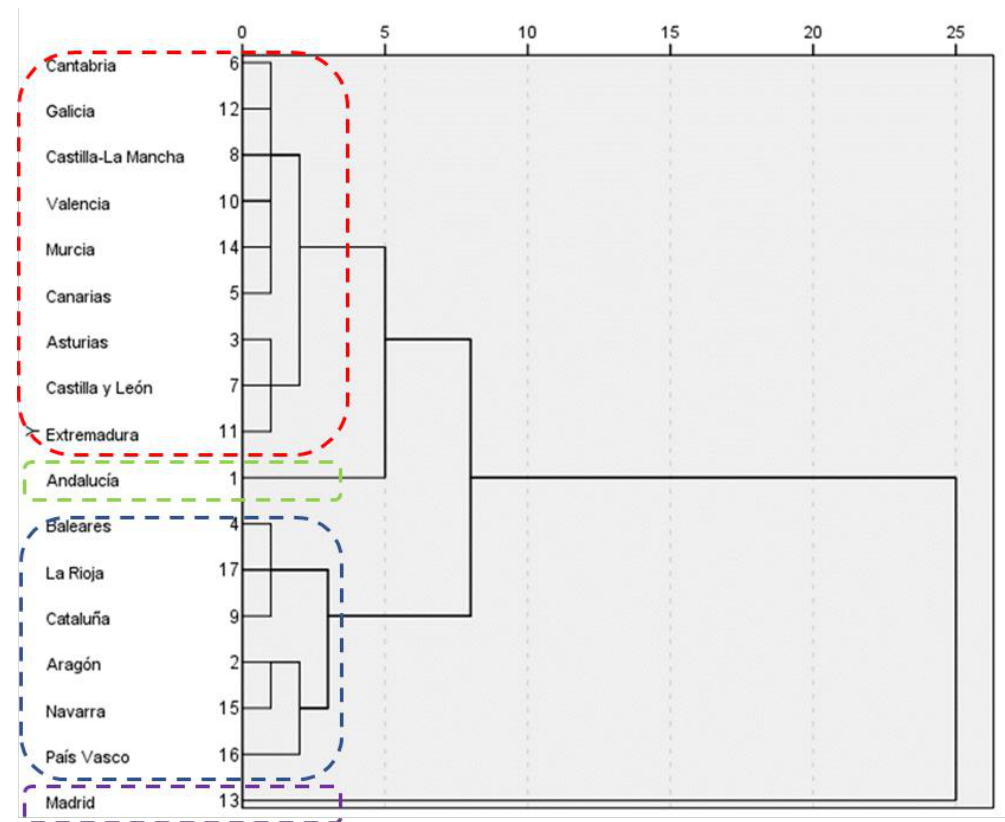
Figure 2. Cluster analysis by distance based on Ward’s method.